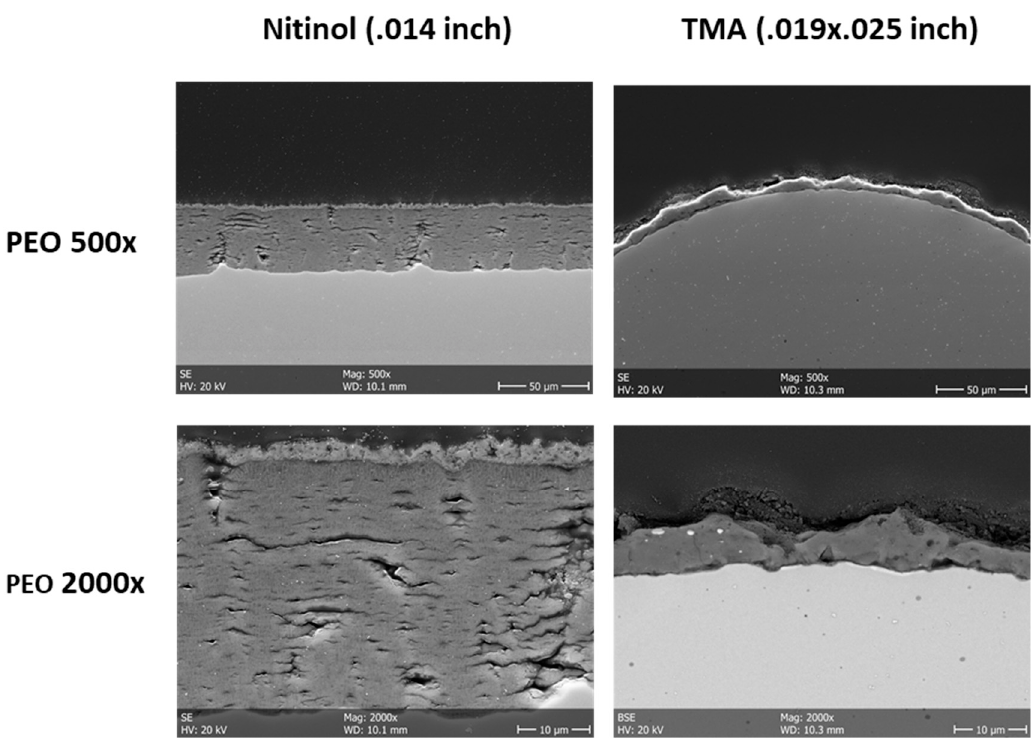
Figure 1. Scanning electron microscopy of non-coated and plasma electrolytic oxidation (PEO)-coated NiTi and β -Ti archwires. The PEO-layer has a sufficient thickness and a certain degree of micro-roughness (left panels: cross-sections, right panels: top views).